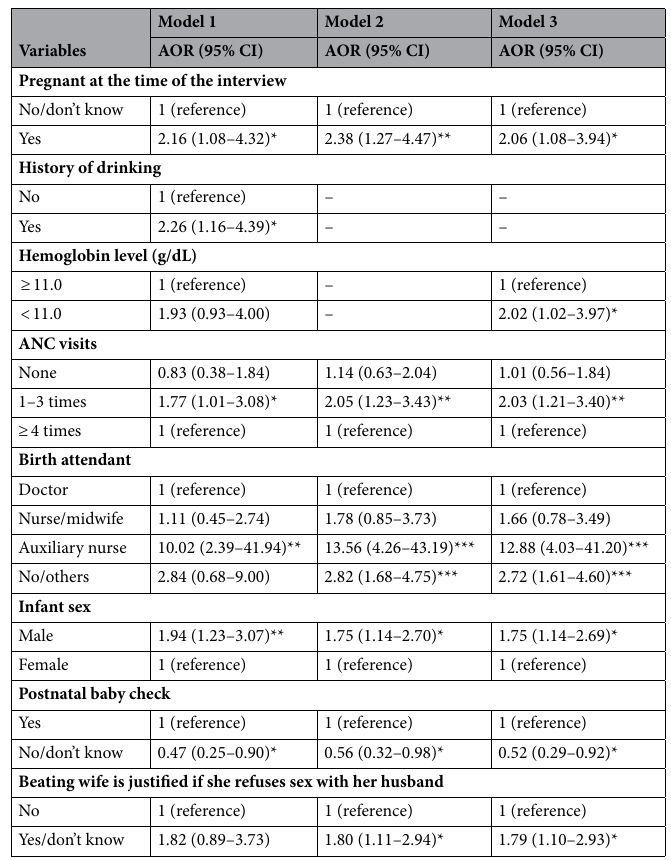
Table 5. Results of multivariate logistic regression models among women with average or large babies at birth. ANC antenatal care, AOR adjusted odds ratio, CI confidence interval. Model 1: forced-entry, Model